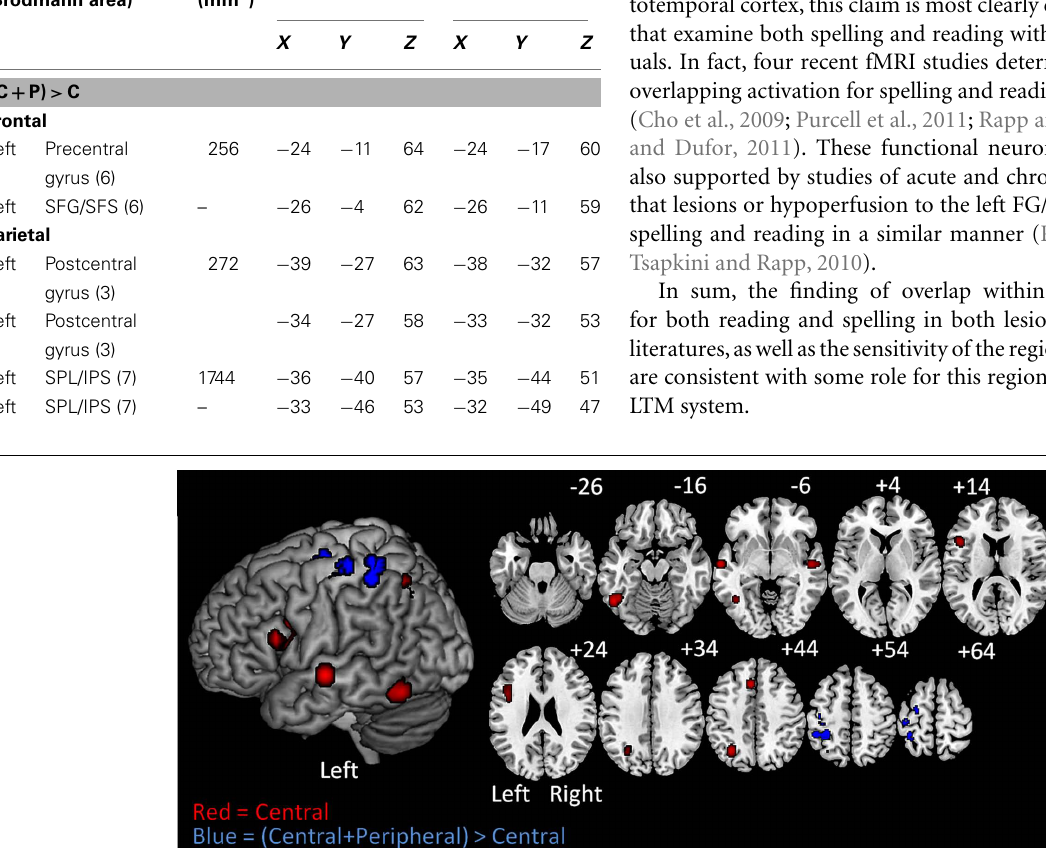
clusters correspond to the central processes of written word production. In blue are the clusters identified in the (central + peripheral) > central-contrast analysis.These clusters correspond to peripheral processes of written